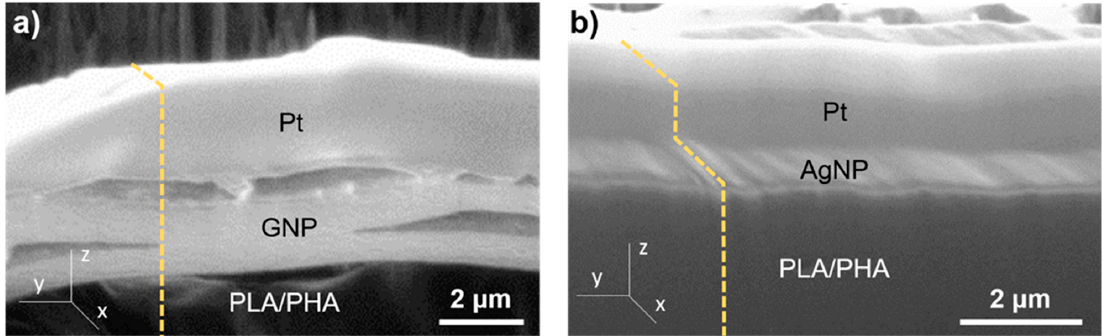
Figure 3. Induced Secondary Electron micrographs of ( a ) PLA/PHA+GNP and ( b ) PLA/PHA+AgNP. Dashed, yellow lines depict the profile of the cross-section in the z -axis.